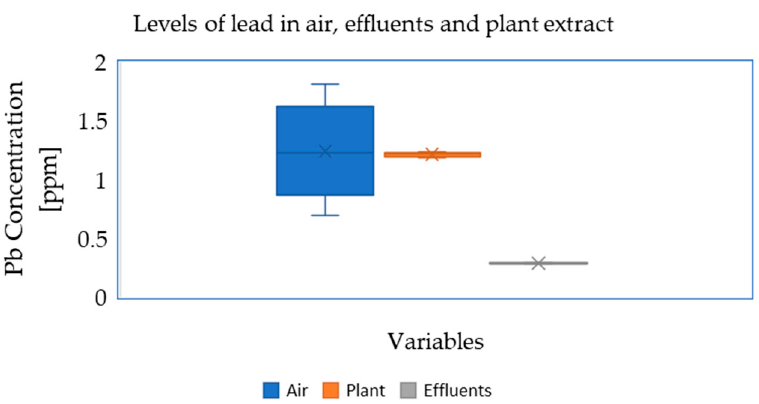
Figure 4. Average variation in Pb concentration in the air, plant leaf extract and effluent wastewater in ppm within Associated Battery Manufacturing (East Africa).